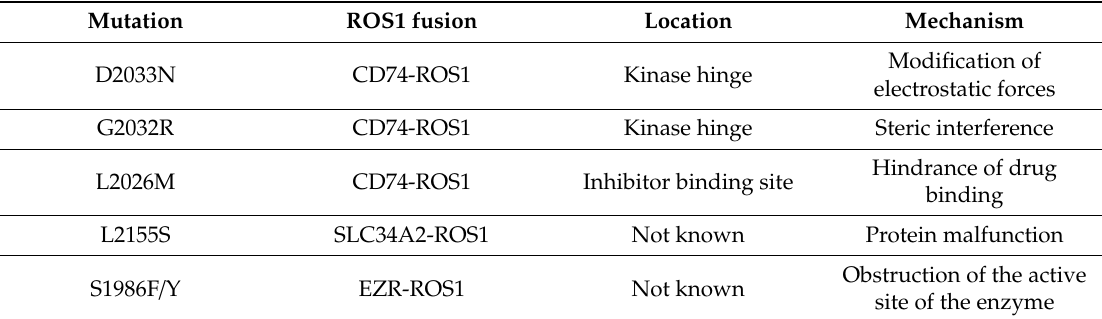
Figure 1. Molecular mechanisms of crizotinib in ROS1-rearranged lung cancer patients. Table 4. ROS1 mutations conferring resistance to crizotinib and mechanism of